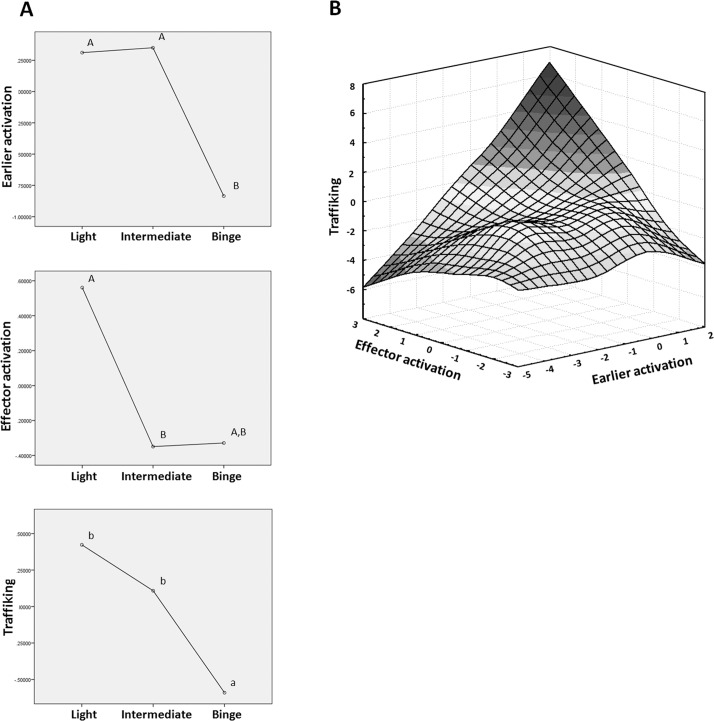
Factorial analysis.
A) One way ANOVA stratified by alcohol consumption pattern and 3 specific factors: Early Activation (Upper graph), Effector Activation (Middle graph) and Trafficking (Lower graph) B) Association of the factors in a XYZ surface plot, Z axis Trafficking factor, X axis Early Activation factor and Y axis Effector Activation factor. a,b,cIndicates homogeneous groups using DMS contrast where a > b > c. A,B,CIndicates homogeneous groups using Tamhane contrast where A > B > C.